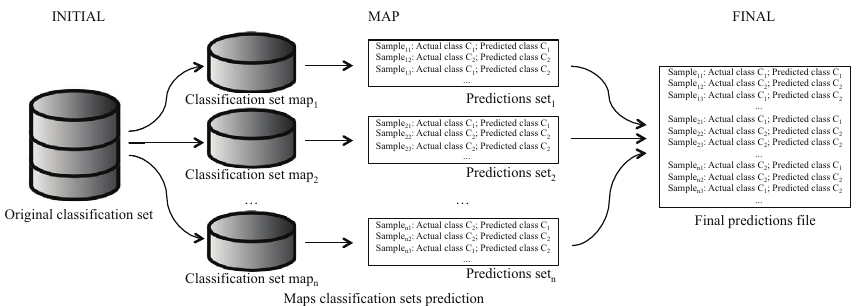
Figure 4: Example of building the KB with Chi-FRBCS-BigData-Ave